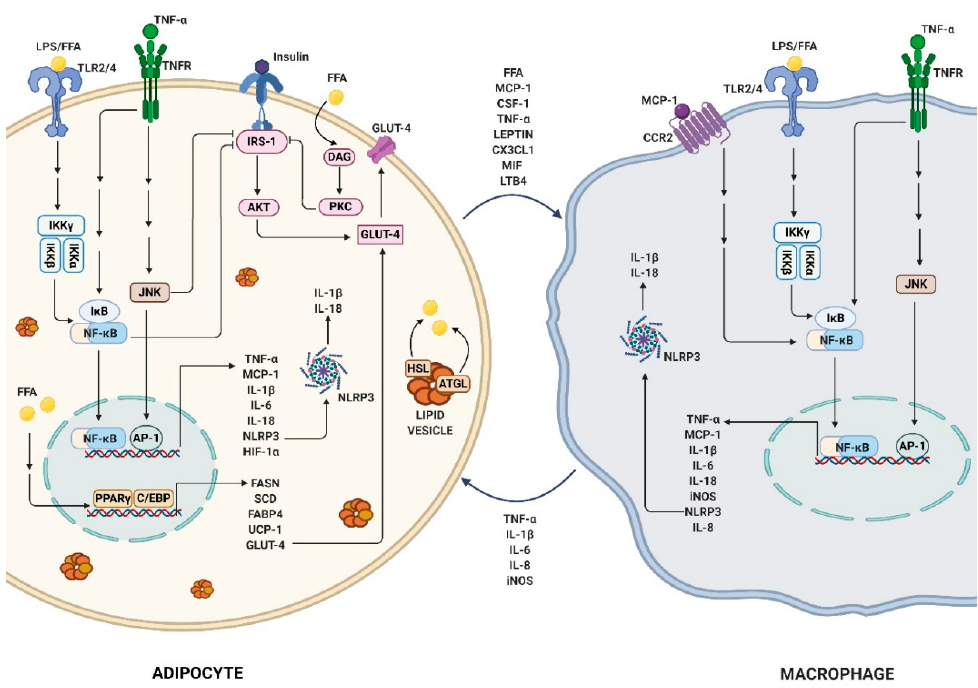
Figure 2. Adipocyte–macrophage crosstalk plays a key role in the induction and maintenance of obesity. Hypertrophic adipocytes release chemoattractants, promoting macrophage infiltration. Adipose-induced adipokines and free fatty acids (FFAs) stimulate adipose tissue macrophages (ATMs) into an M1 inflammatory stage to trigger JNK, NF- κ B, and NLRP3-mediated pathways and inflammatory cytokines, which further induce adipocyte responses, including PPAR γ and C/EBPs-regulated expressions of adipogenic, thermogenic, lipolytic, and lipogenic genes.